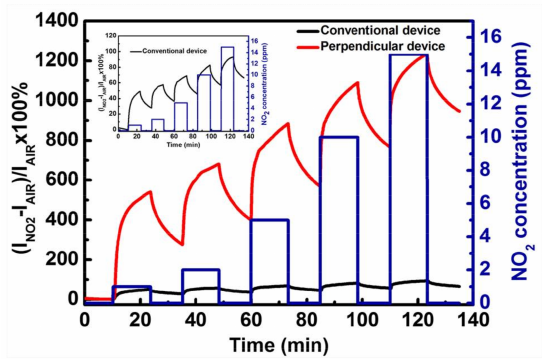
Figure 5. Response curves of conventional and perpendicular devices to NO 2